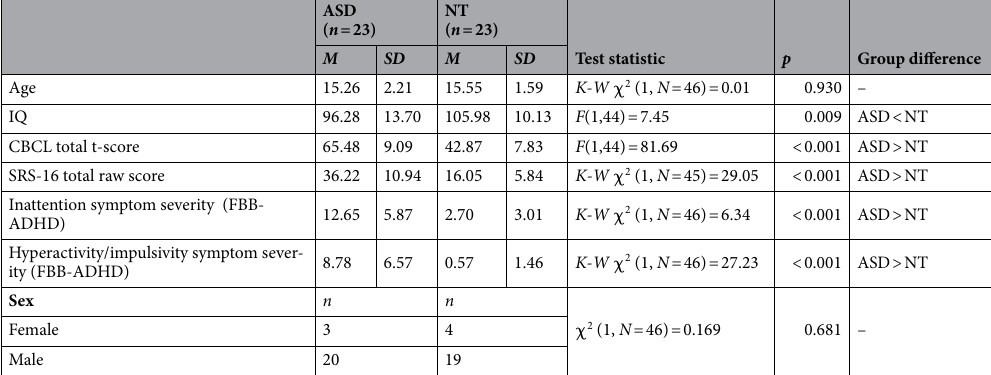
Table 1. Study sample characteristics. ASD: Autism Spectrum Disorder; NT: neurotypical control group; IQ: intelligence quotient; K-W χ 2 , CBCL: Child Behaviour Checklist/4-18R: SRS-16: Social Responsiveness Scale - short form; ADHD: Attention-Deficit/Hyperactivity Disorder; FBB-ADHD: FBB-ADHD rating scale for